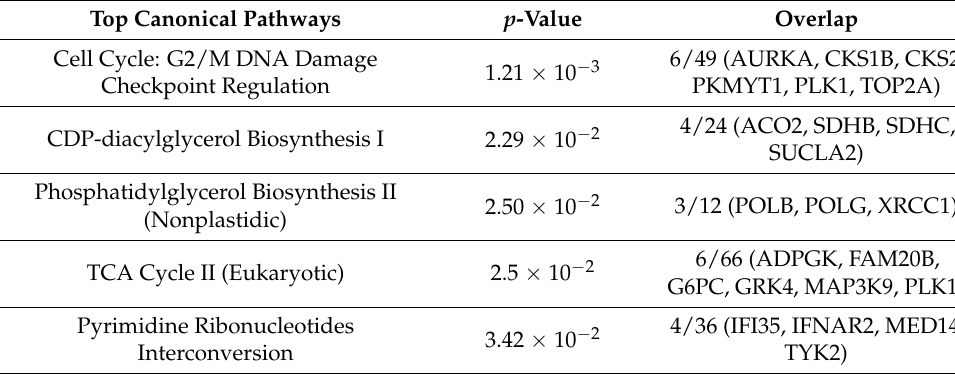
Table 2. Major canonical pathways affected by RYGB. Top Canonical Pathways Cell Cycle: G2/M DNA